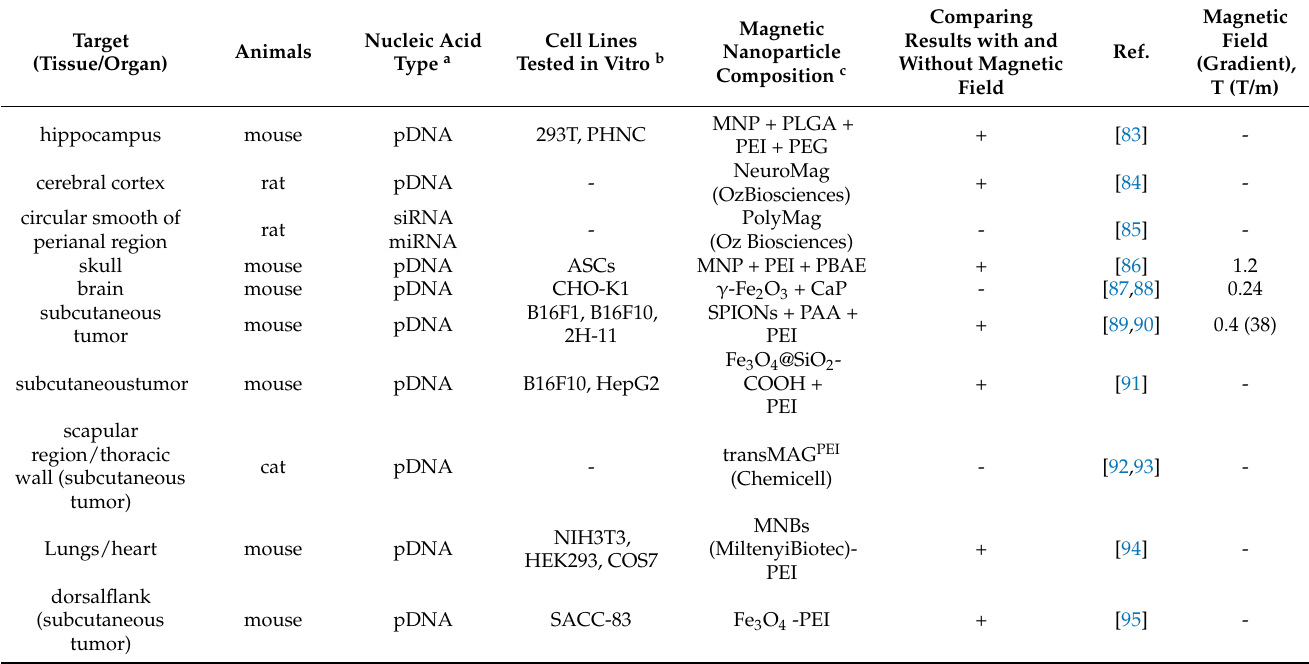
Table 1. Target (tissue/organ), nucleic acid type, magnetic nanoparticle composition, cell lines tested in vitro, and available characteristics of magnetic field summarized from the literature